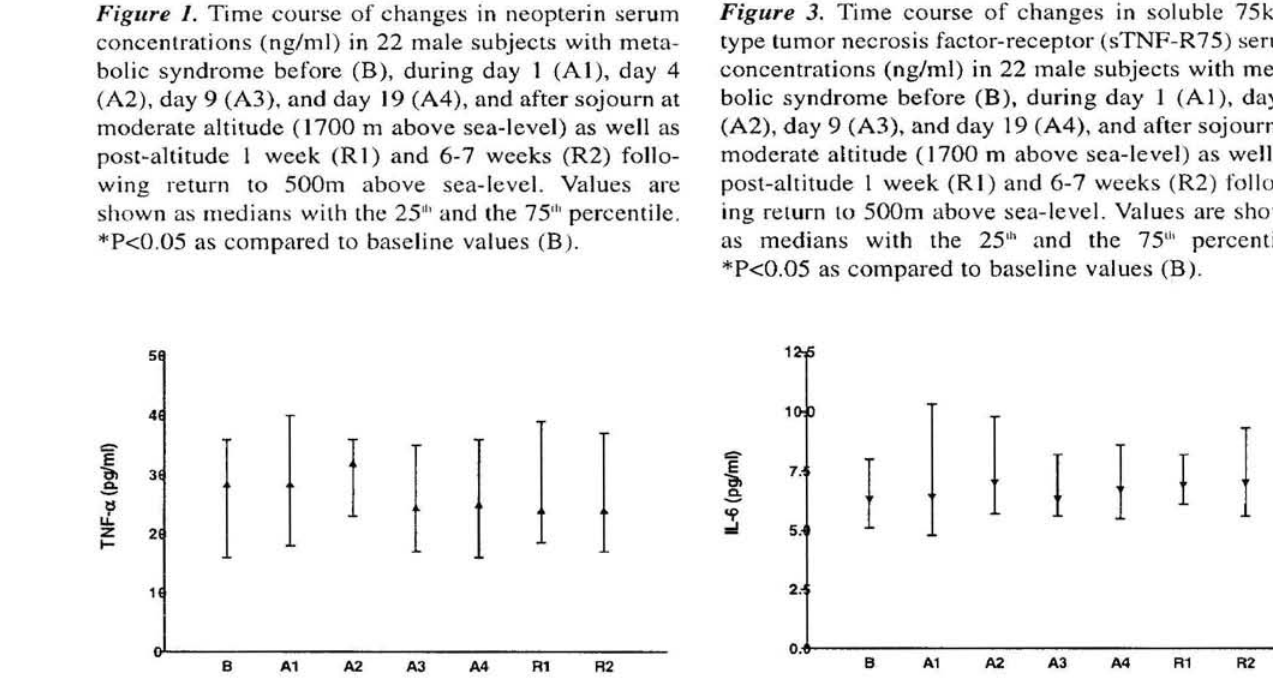
Figure 4. Time course of changes in interleukin-6 (IL- 6) serum concentrations (ng/ml) in 22 male subjects with metabolic Syndrome before (B), during day 1 (AI), day 4 (A2), day 9 (A3), and day 19 (A4), and after sojourn at moderate altitude (1700 m above sea- level) as well as post-altitude 1 week (Rl) and 6-7 weeks (R2) following return to 500m above sea-level. Values are shown as medians with the 25"' and the 75"'